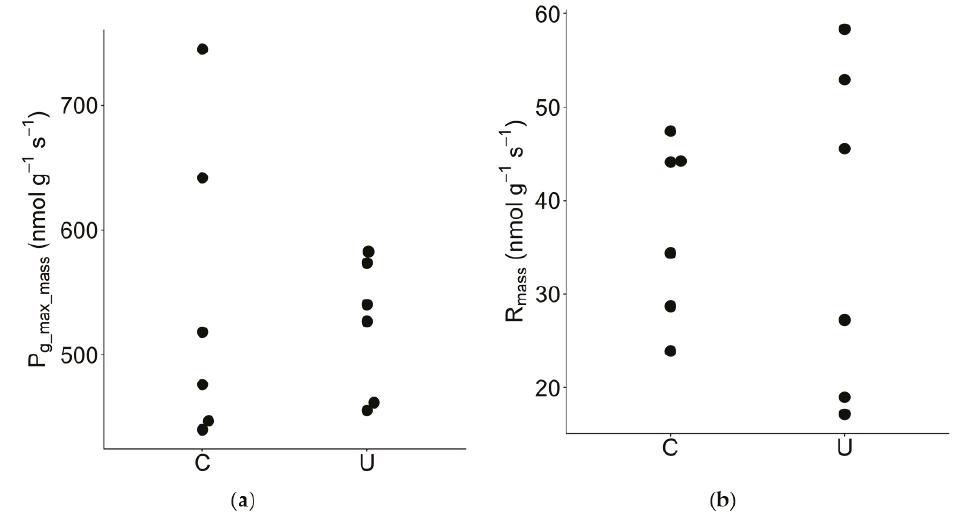
Figure 8. Mass-based ( a ) photosynthetic rates and ( b ) dark respiration rates of the sun leaves in the clearing (C) and the shade leaves in the understory (U). Each closed circle indicates one